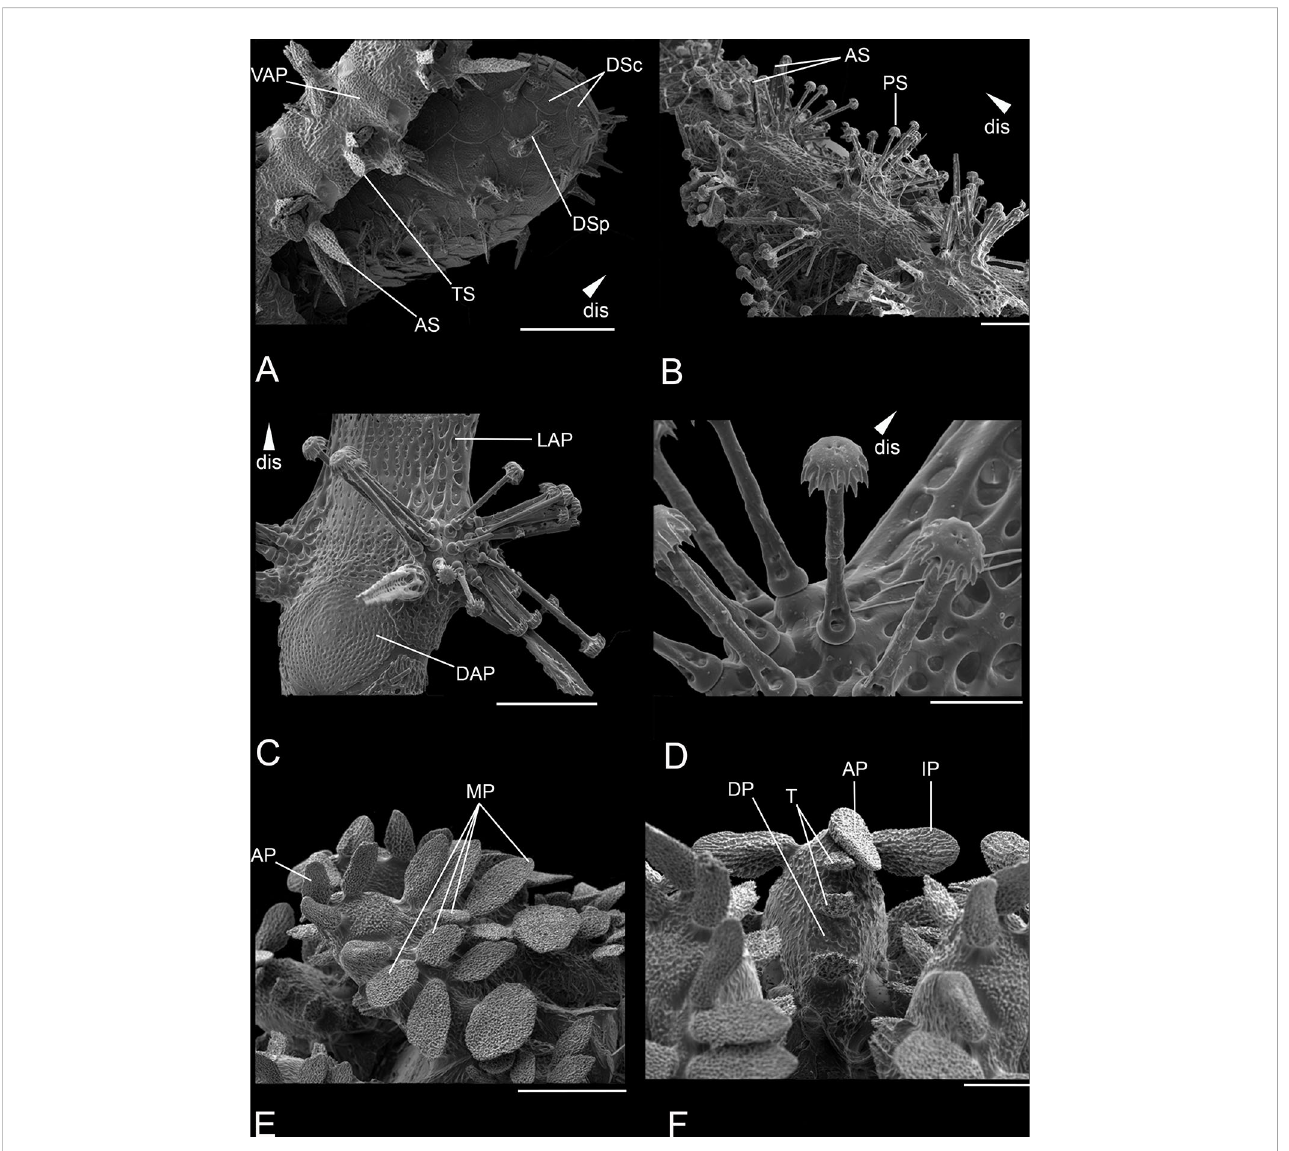
FIGURE 9 Scanning electron microscope images of close ups from the habitus of Ophiotholia saskia sp. nov. (SO240_46_5). (A) : Disc with plates and proximal part of an arm; (B) : Distal part of an arm; (C) : Set up of an arm segment; (D) : Set up of the articulations with inserted parasol-spines; (E) : Set up of a jaw with papillae; (F) : Teeth and papillae. Scales: 30 µm (C) ; 80 µm (F) ; 200 µm (A, E) ; 400 µm (B) ; 1 mm (D) . ab, abradial; AP, apical papillae; AS, arm spine; ASA, arm spine articulation; DAP, dorsal arm plate; DP, dental plate; dis, distal; DSc, disc scale; DSp, disc spine; IP, infradental papillae; LAP, lateral arm plate; MP, mouth papillae; PS, parasol spine; PSA, parasol spine articulation; T, tooth; TS, tentacle scale; VAP, ventral arm